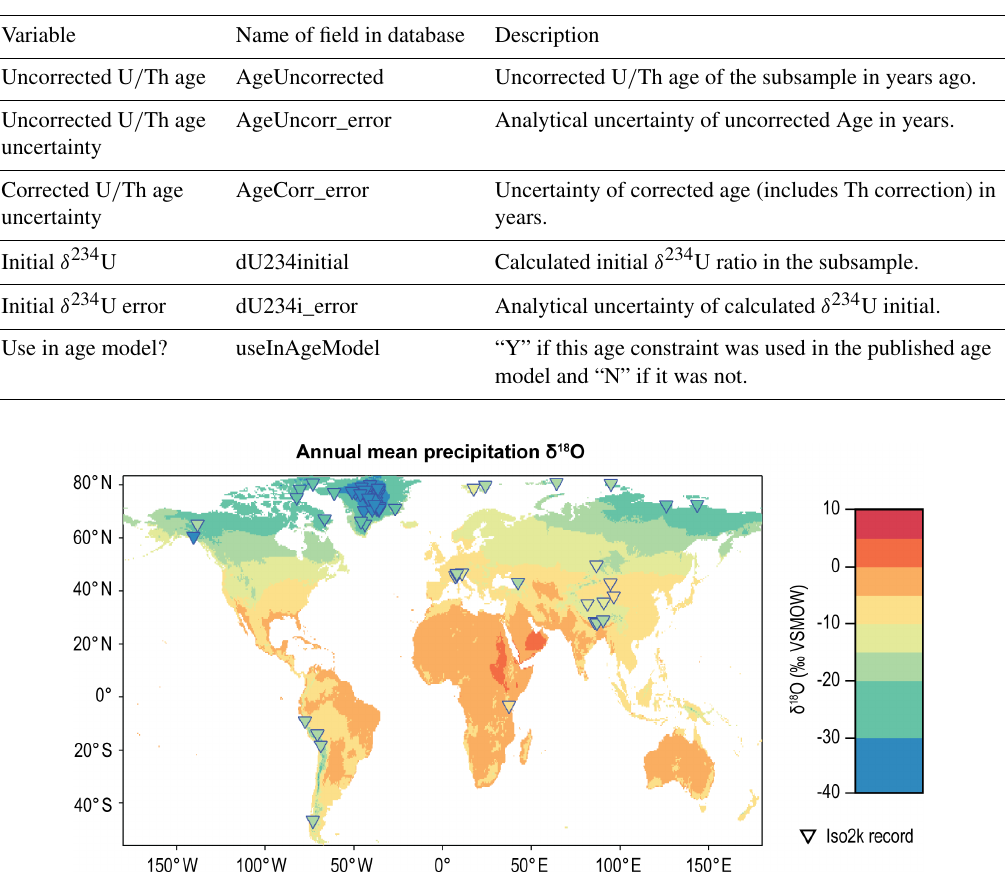
Figure 5. Average δ 18 O from glacier and ground ice records in the Iso2k database (symbols), calculated as the average value since 1900CE, compared with mean annual δ 18 O from the Global Network of Isotopes in Precipitation (GNIP) (shading) (Terzer et al., 2013). Antarctica is excluded from this map due to the scarcity of GNIP